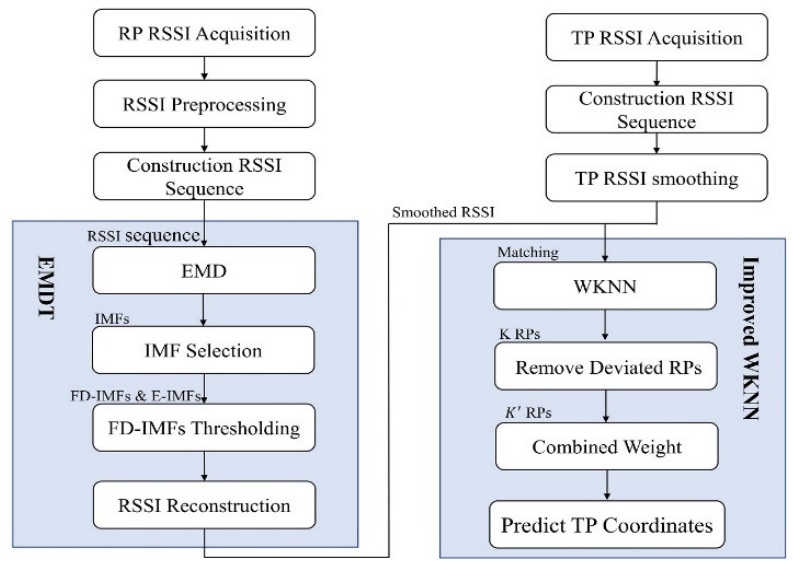
Figure 6. The framework of the EMDT-WKNN-based indoor positioning method.